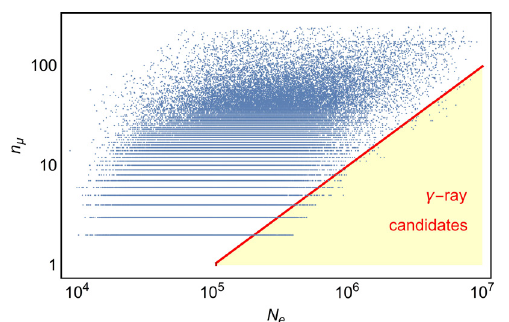
Table 1. Upper limits on the integral flux of gamma rays above 1 PeV from four pre-defined